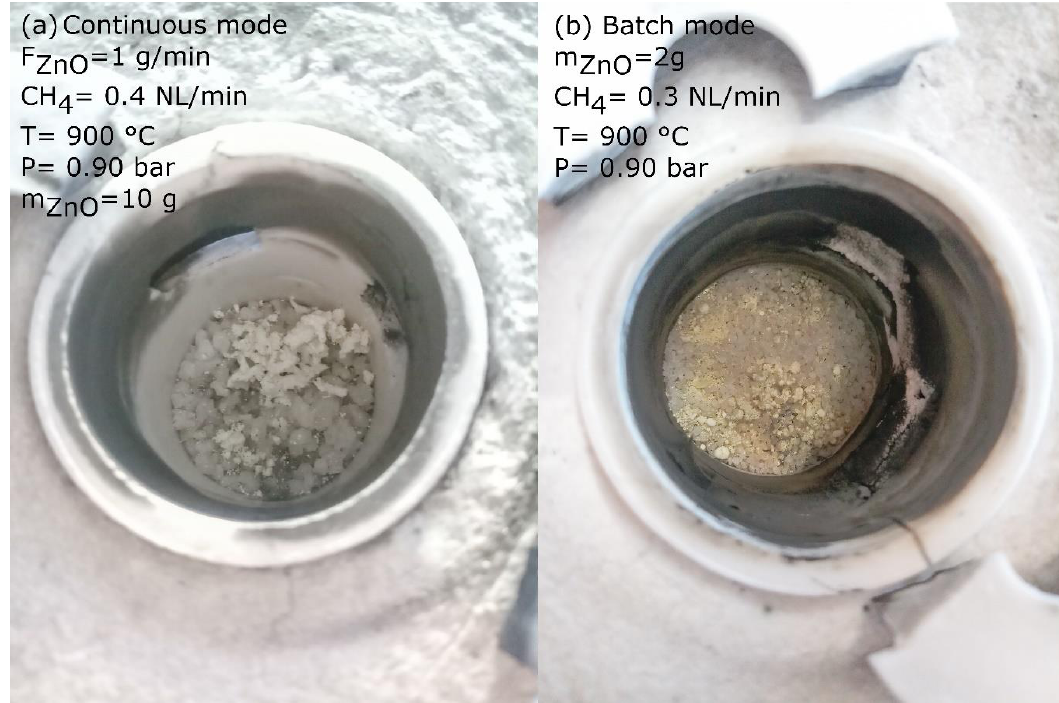
Figure 8. ZnO remaining at 900 °C and 0.90 bar: ( a ) in continuous mode and ( b ) in batch mode. Source: author.